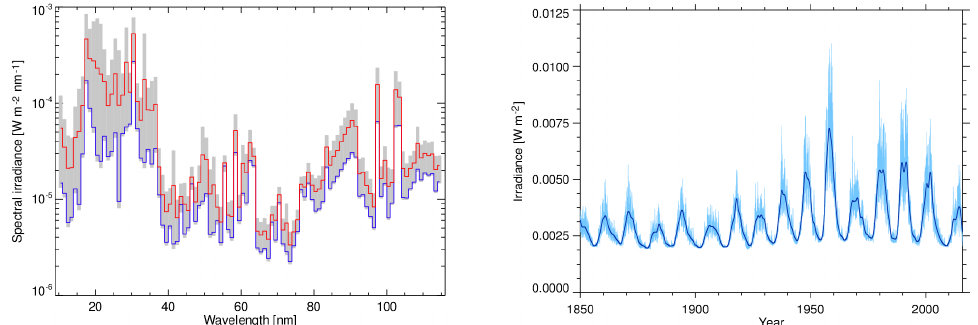
Figure 5. Left: EUV spectra for 20 November 2008 (corresponding to low solar activity conditions, in blue) and 8 February 2002 (corre- sponding to high solar activity conditions, in red). The full spectral variability range during 1850–2015 is grey-shaded. Right: time series of the EUV irradiance integrated from 15 to 105nm. The thick blue line corresponds to annual